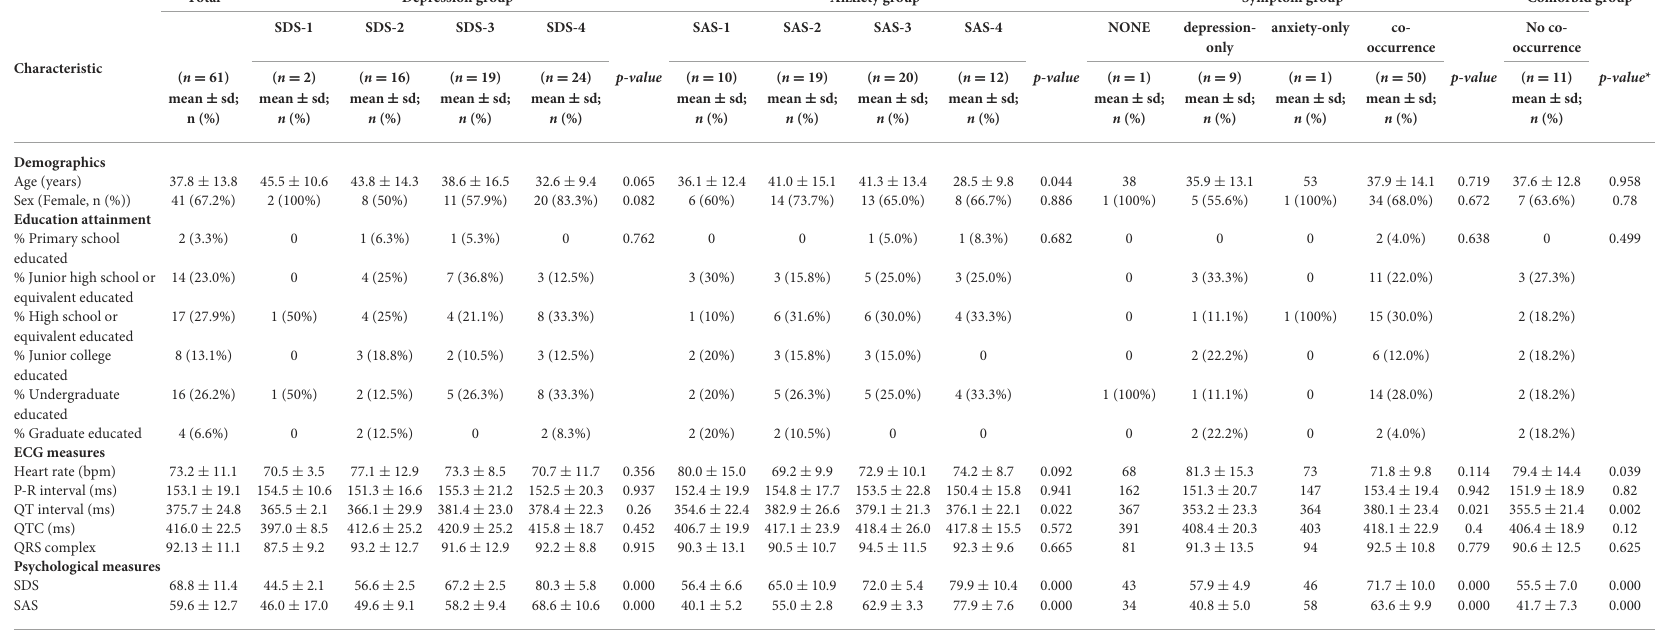
TABLE 1 Demographic and clinical characteristics of